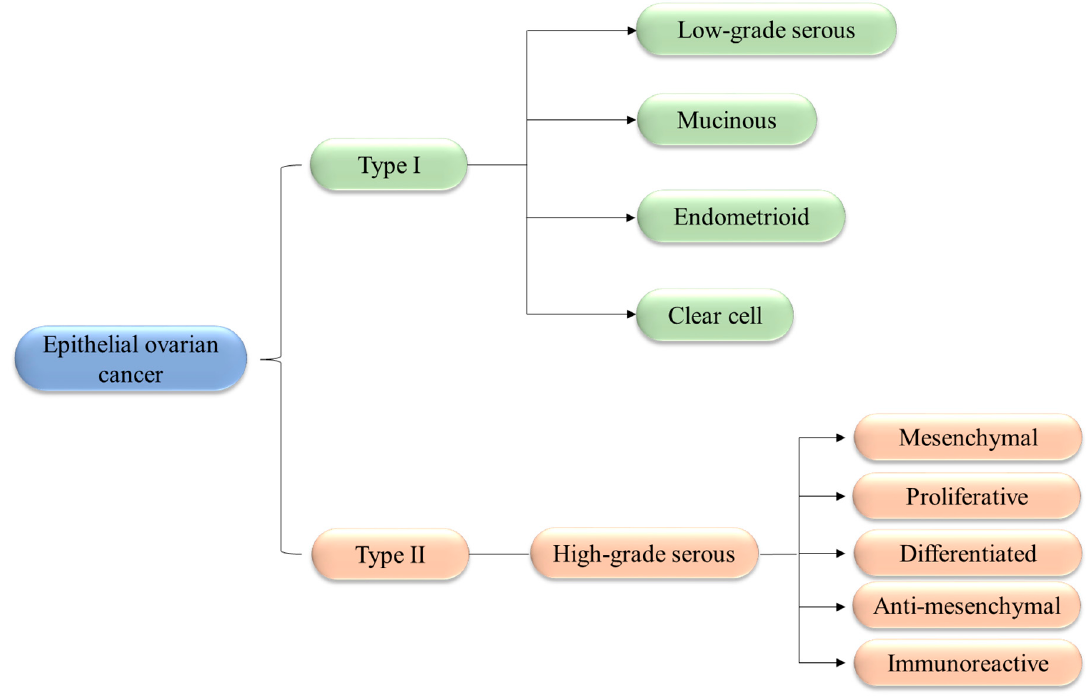
Figure 1. Histological classification of epithelial ovarian carcinoma.